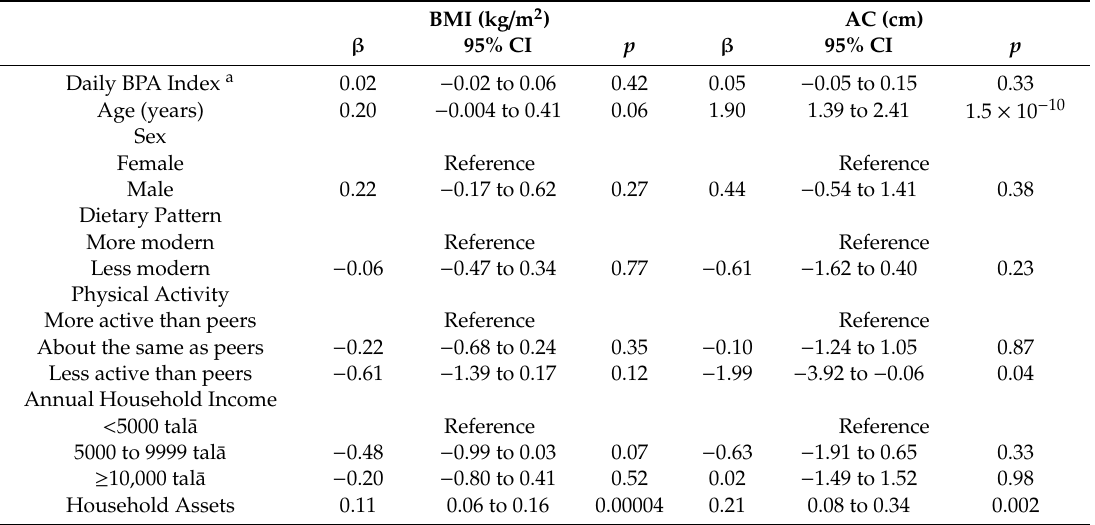
Table 6. Results of multiple linear regression examining associations between daily BPA index and body mass index and abdominal circumference in children ( n = 370) while adjusting for